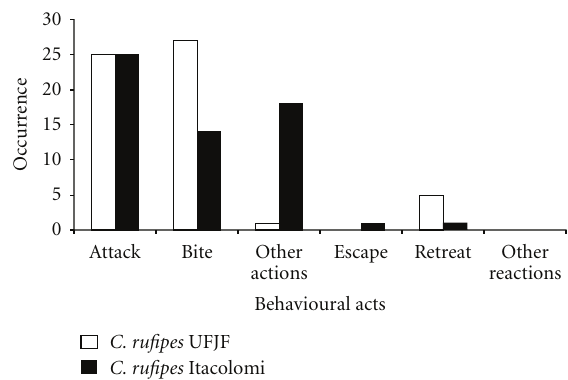
Figure 3: Action and reaction behavioural occurrences for the C. rufipes colonies at the Itacolomi State Park (Itacolomi) and campus of Federal University of Juiz de Fora (UFJF) during field experi- ments. The “other actions” and “other reactions” behaviours are grouped together because of their low frequency.